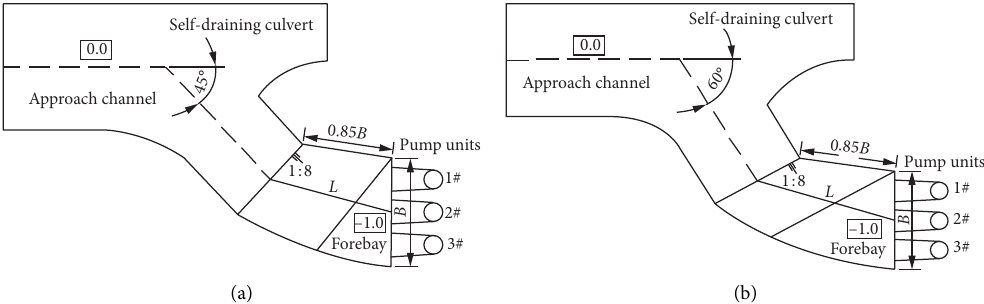
Figure 1: Drawings of pumping station intake buildings under different lateral bending. (a) Layout drawing of the intake building of the pumping station at a 45 ° bending. (b) Layout drawing of the intake building of the pumping station at a 60 ° bending.